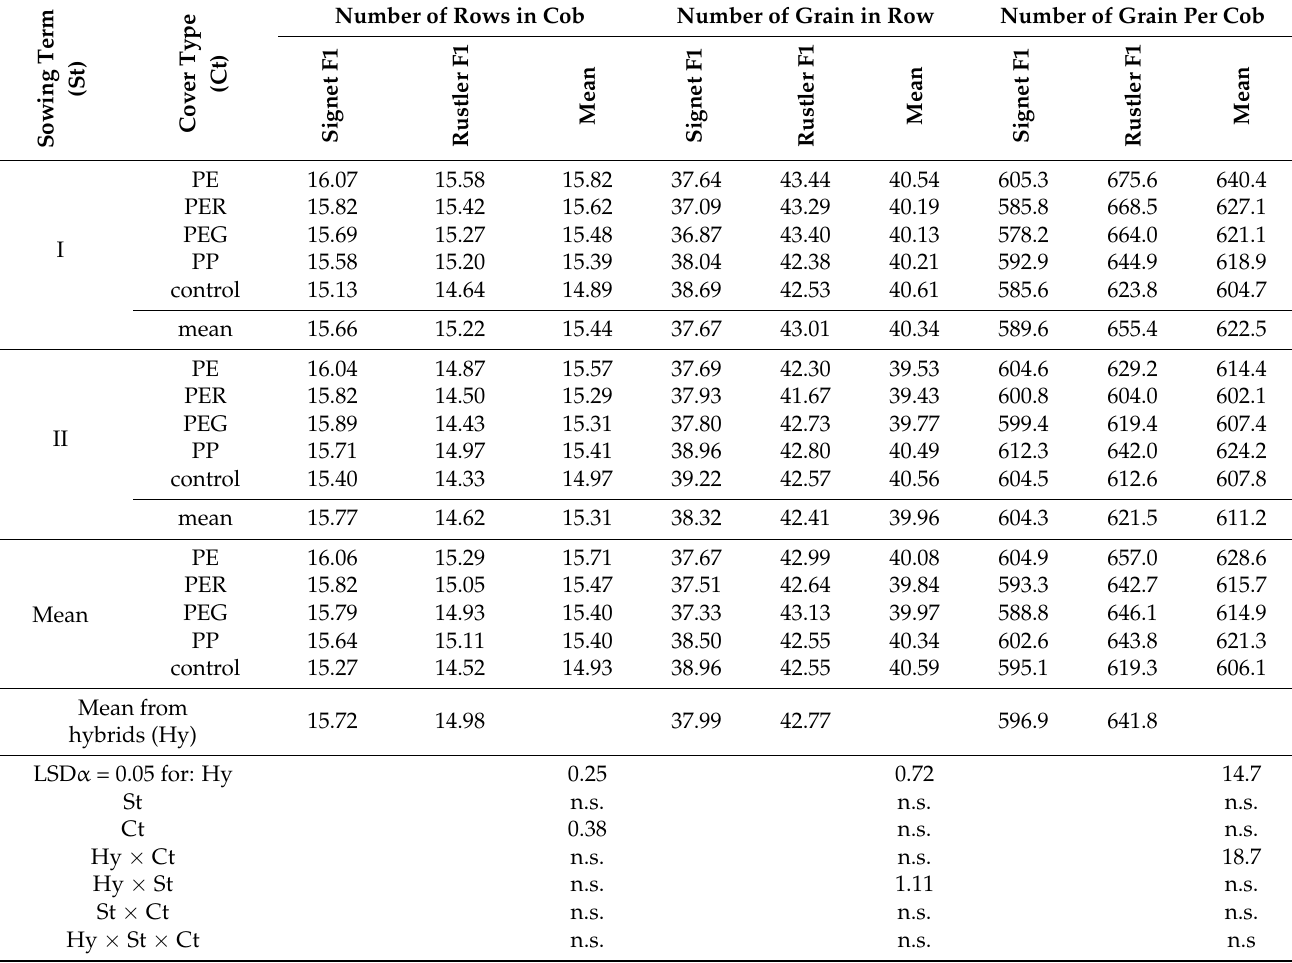
Table 3. Total cobs yield (dt per ha) and percentage (%) of marketable cobs yield. Average from years 2012–2014. Table 2. The effect of experimental treatments on the morphological parameters of cobs. Average from years 2012–2014.